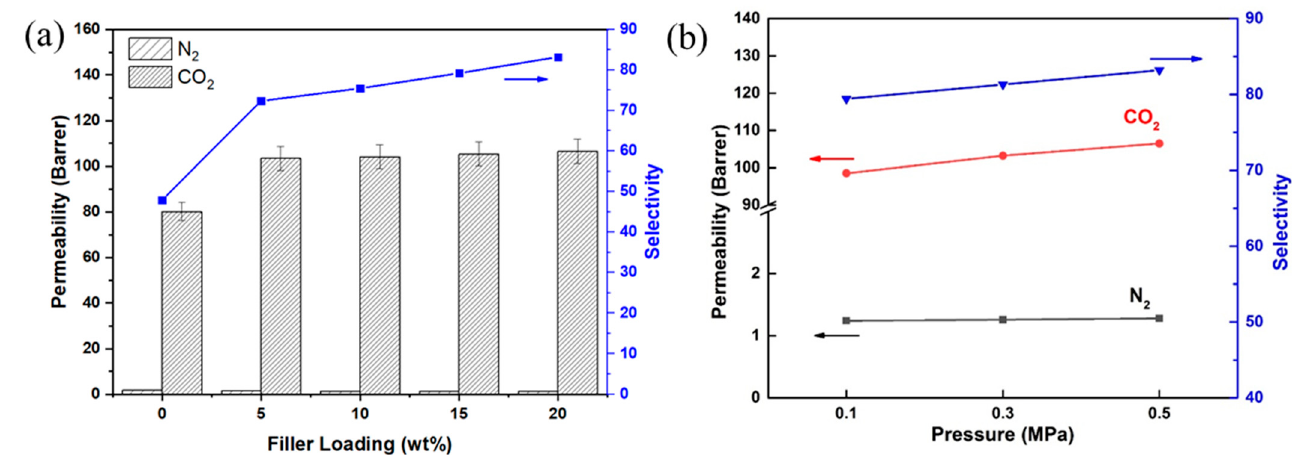
Figure 6. Gas permeation tests of ZIF-8@BNNS/Pebax MMMs ( a ) CO 2 and N 2 permeability and CO 2 /N 2 selectivity of the membranes with different ZIF-8@BNNS loadings (0, 5 wt.%, 10 wt.%, 15 wt.%, and 20 wt.%), ( b ) CO 2 permeability and CO 2 /N 2 selectivity at different pressures (20 wt.% loading).